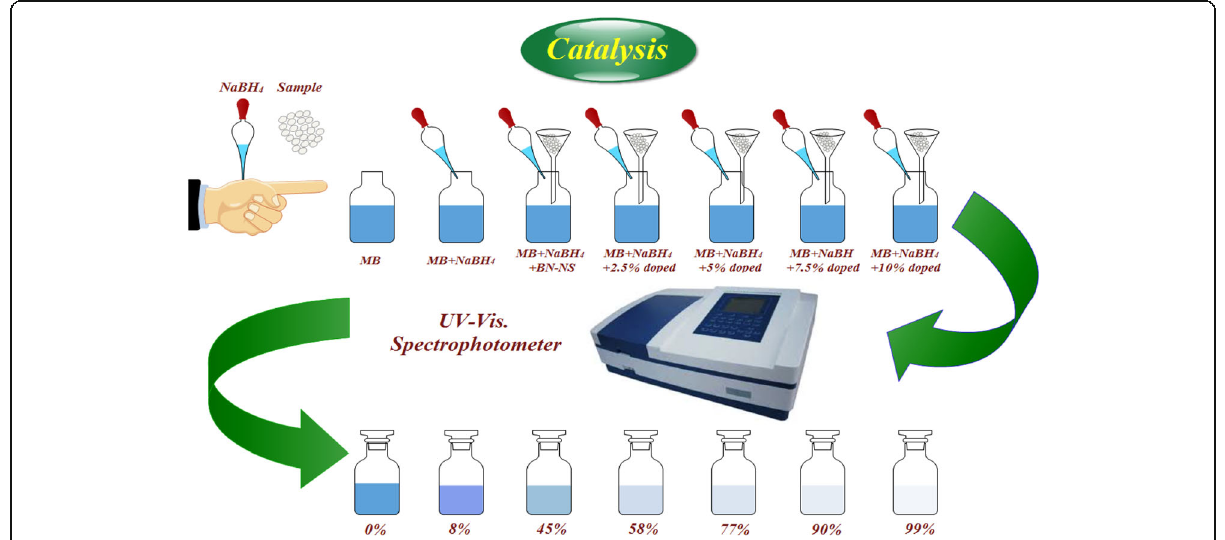
Fig. 2 Schematic illustration of the experimental setup used to evaluate the catalytic activity